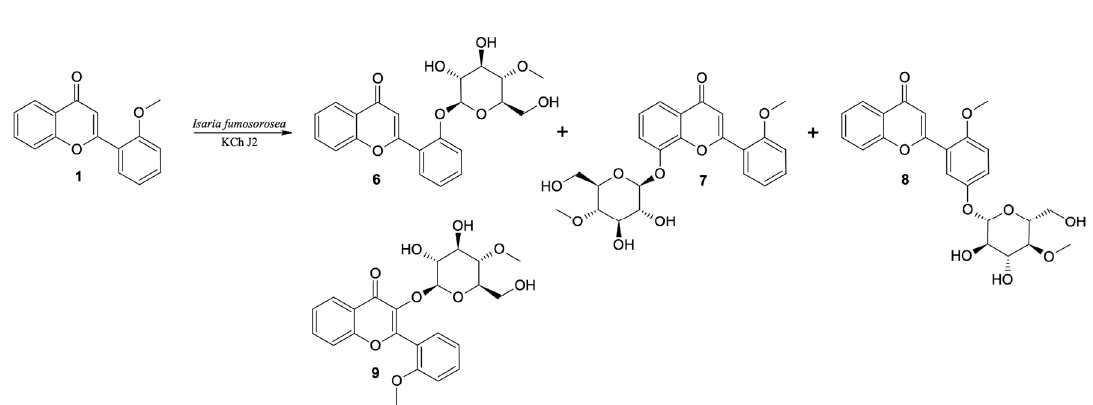
Table 2. Isaria fumosorosea KCh J2 transformation of 2 ′ -methoxyflavone (glycosylated derivatives), UHPLC conversion.